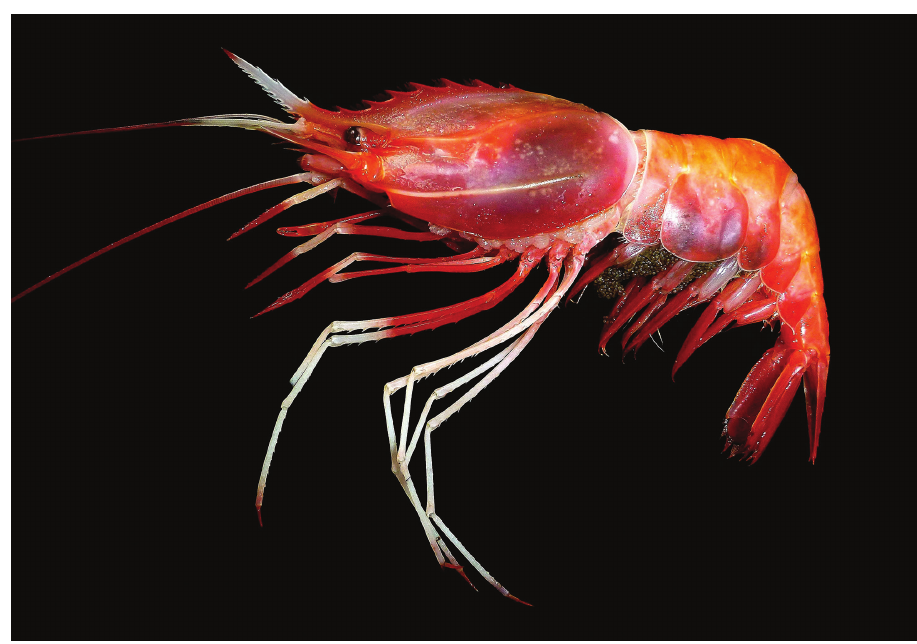
Figure 1. Heterocarpus chani Li, 2006, Sakthikulangara fishing harbor, SW India, ovigerous ♀ cl 29.9 mm (NTOU